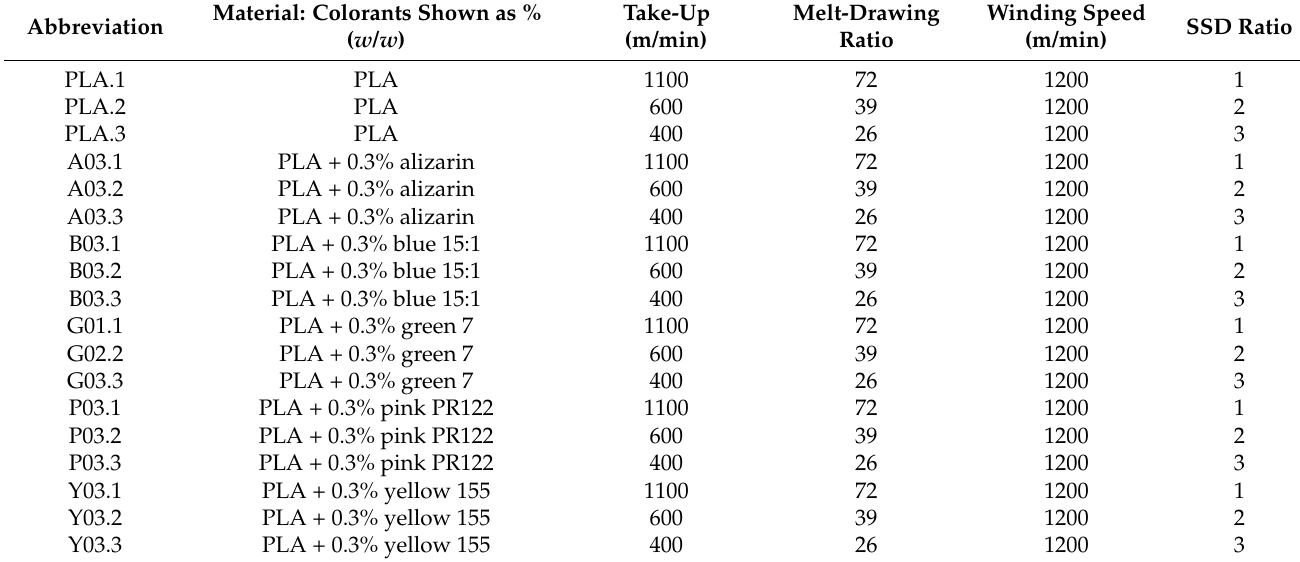
Table 2. Complete set of yarns produced under different experimental